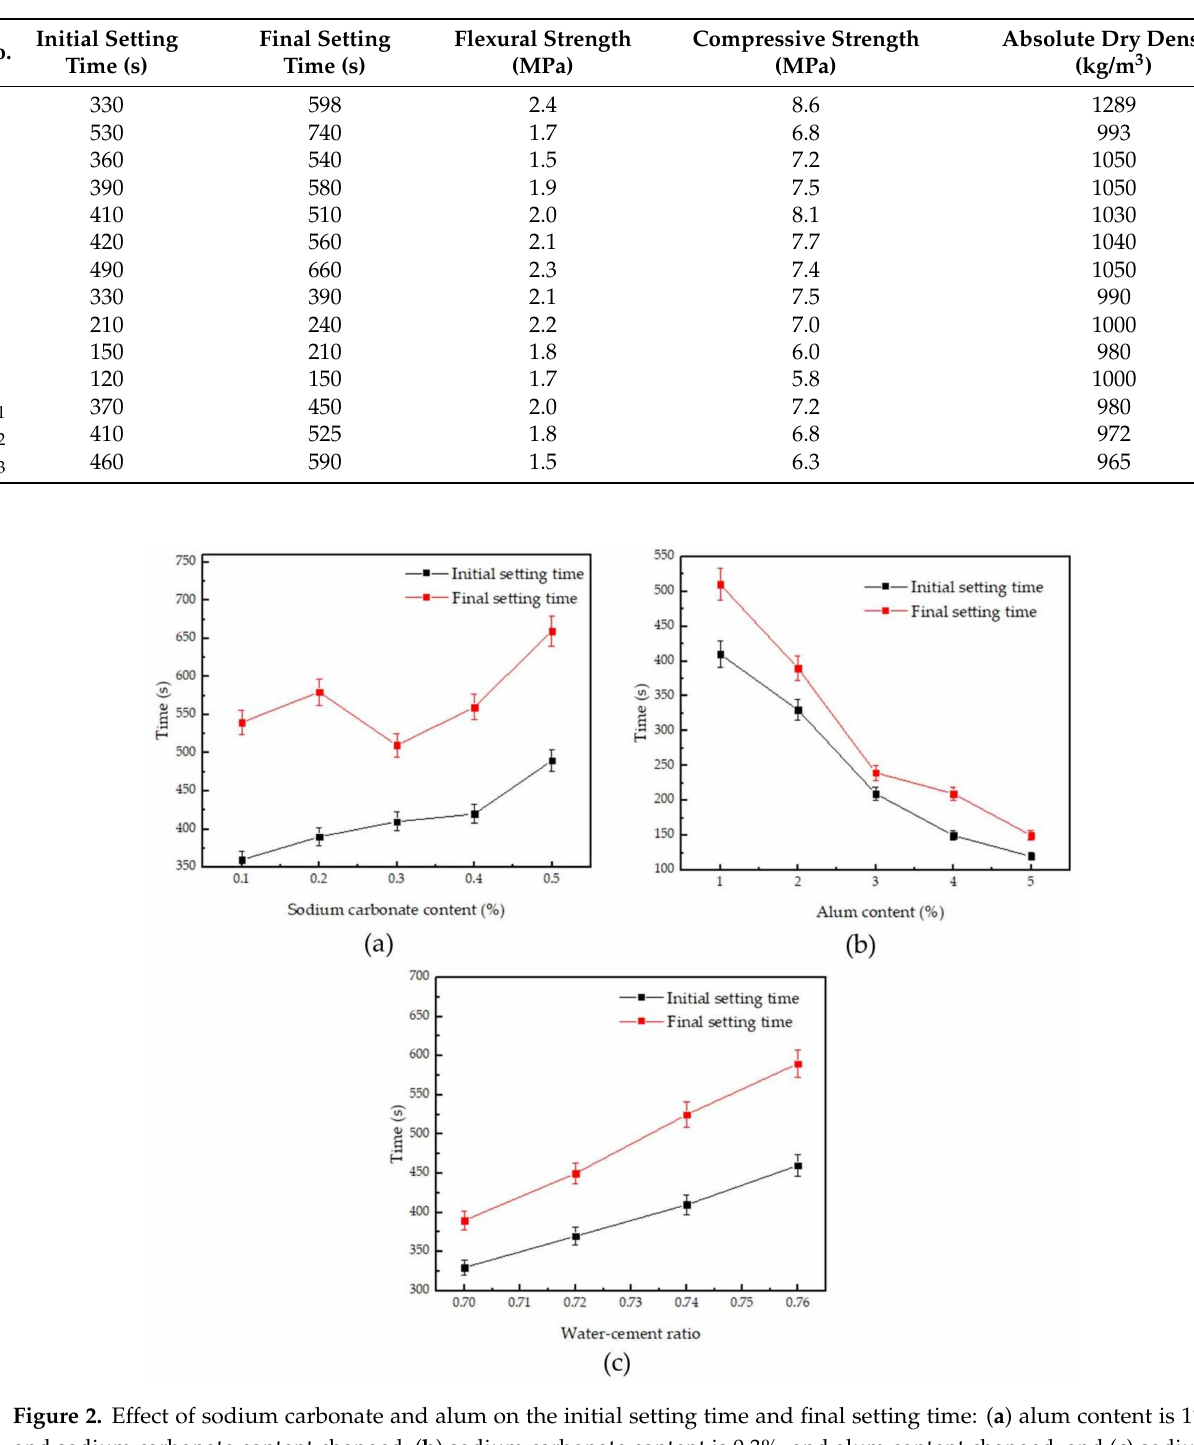
Table 2. Effects of different contents of sodium carbonate and alum on properties of phosphogypsum.